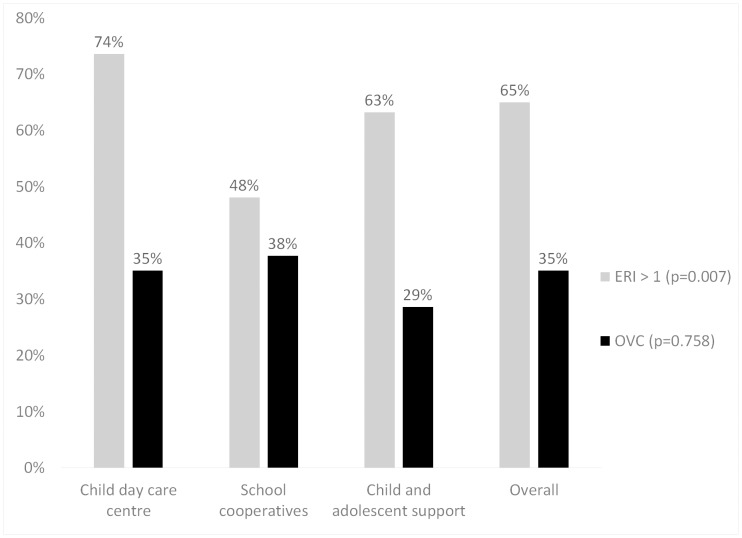
Distribution of the ERI components in the different institutions.